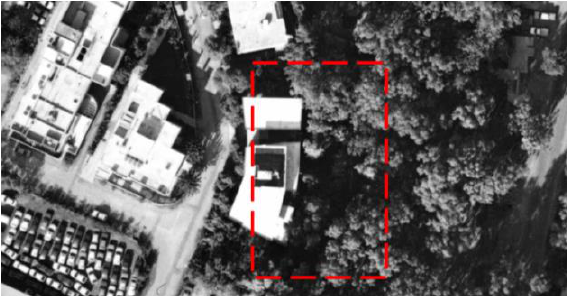
Figure 5. Neoptolemos and Maria residence- top